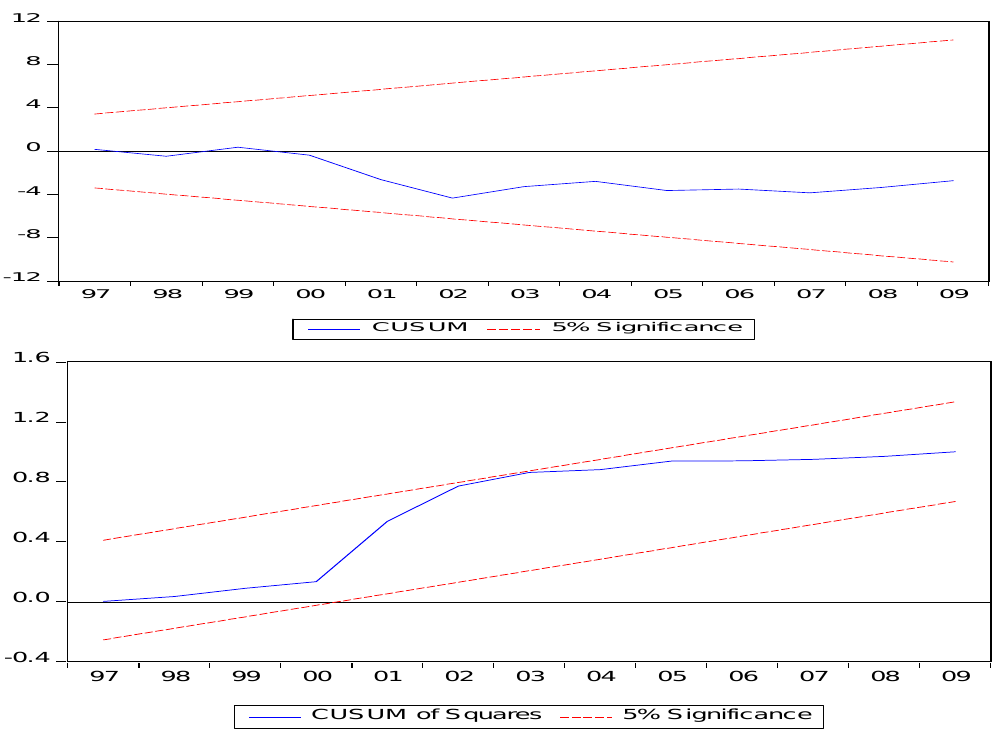
Figure 4. Reliability and stability test of coefficients.